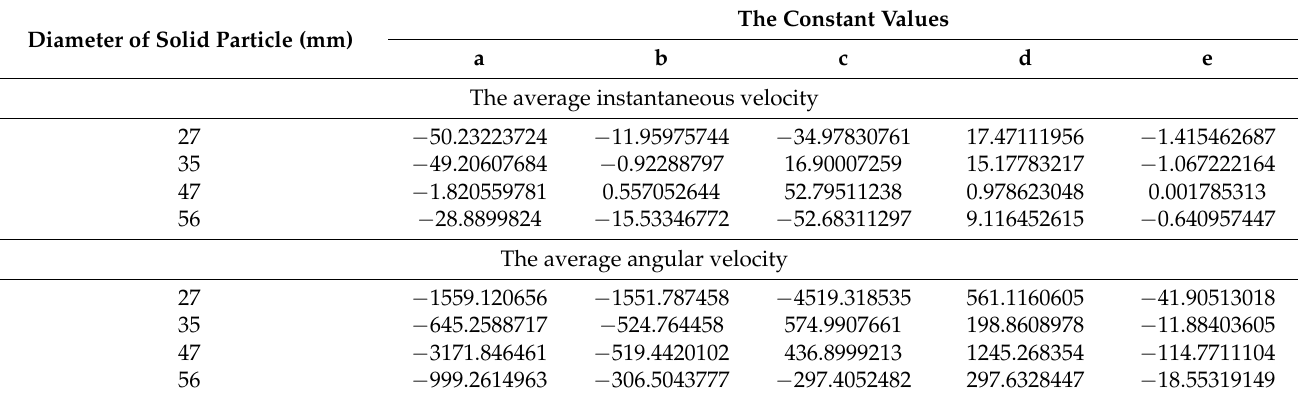
Table 3. The numerical value of the terms in the mathematical equations [44].